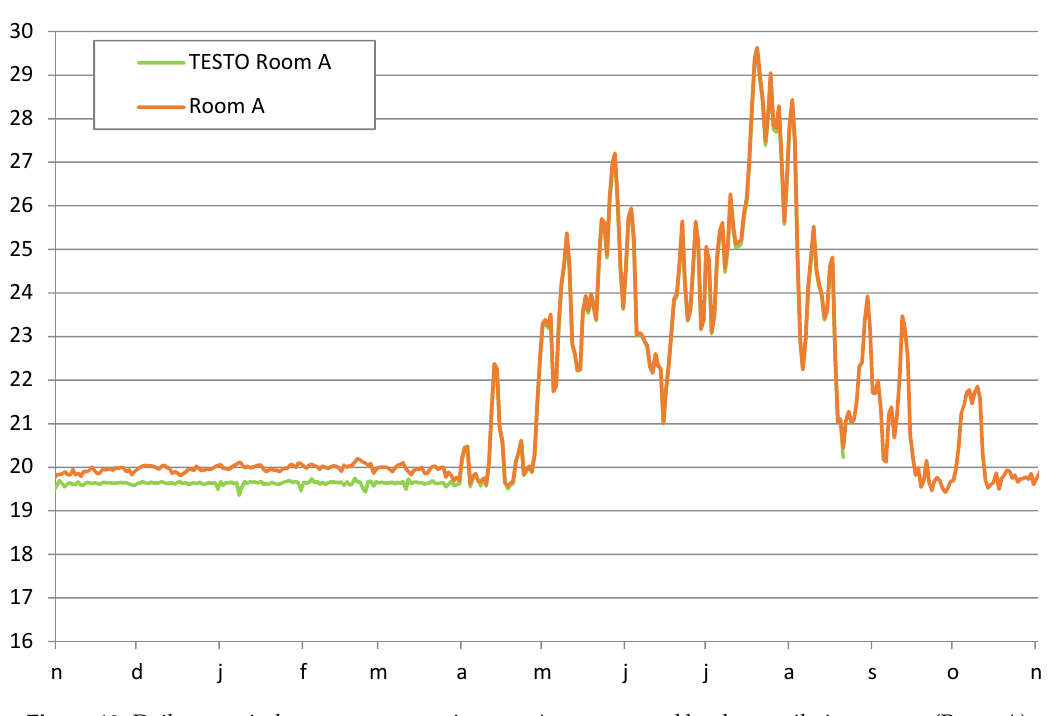
Figure 11. Daily mean indoor temperatures in room B, as measured by the ventilation system (Room B) and by the TESTO device (TESTO Room B). In general, the room temperatures measured by the ventilation system were somewhat higher than the temperatures measured by the TESTO devices. This was particularly the case during the